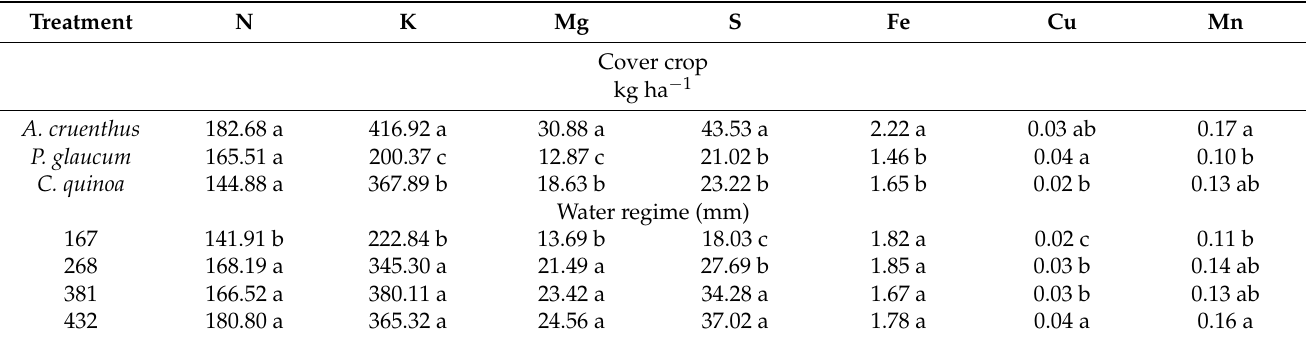
Table 4. Isolated effect of cover crops and water regimes on the accumulation of macro- and micronu- trients in the shoot biomass of the three cover crops.